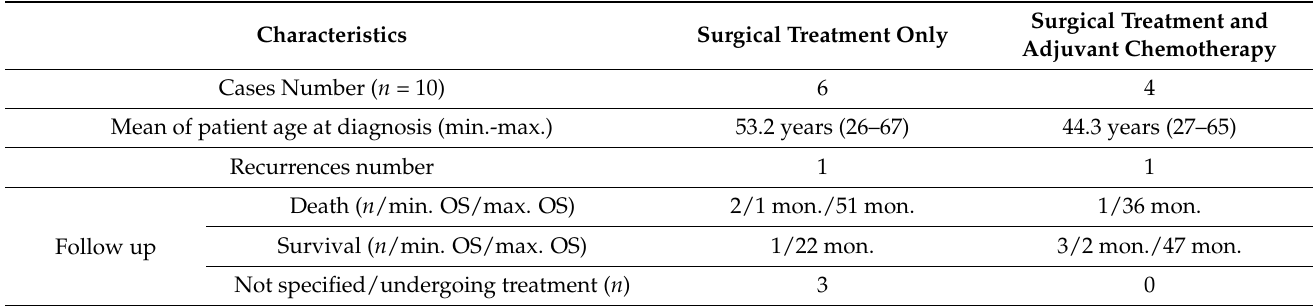
Table 2. Comparison of selected features between group treated with surgery only and group treated with surgery and adjuvant chemotherapy in primary leiomyosarcoma of the ovary. Surgical Treatment and Characteristics Surgical Treatment Only Adjuvant Chemotherapy 6